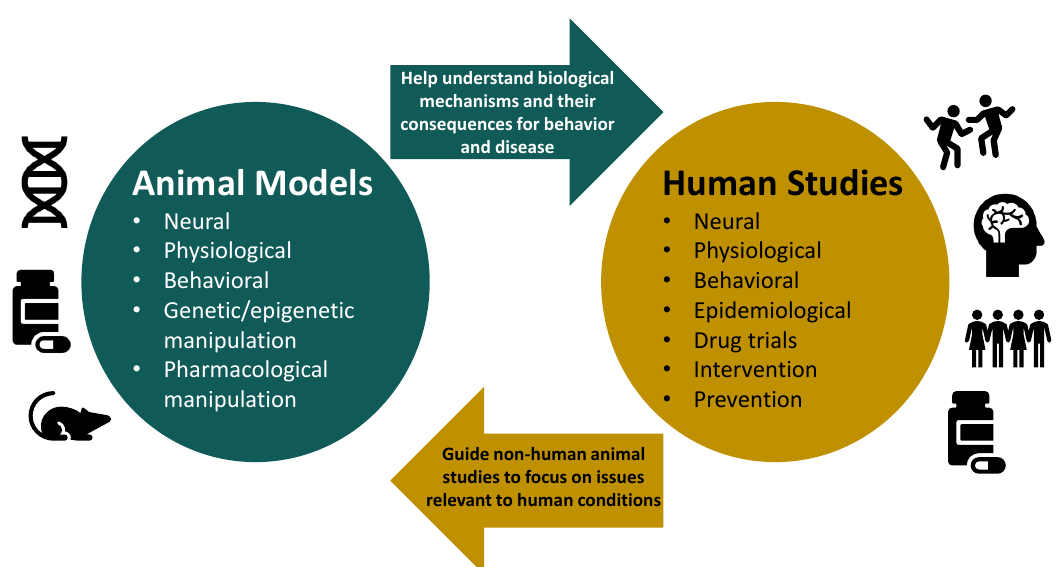
Figure 1. The relationship between animal models and human studies is reciprocal: both provide important insight into biology and behavior, guide the direction of one another’s research, and complement each other’s findings. With non-human animal models, however, we can utilize genetic, epigenetic, and pharmacological manipulations to help elucidate mechanisms and establish causality between environmental factors and behavior, health, and disease